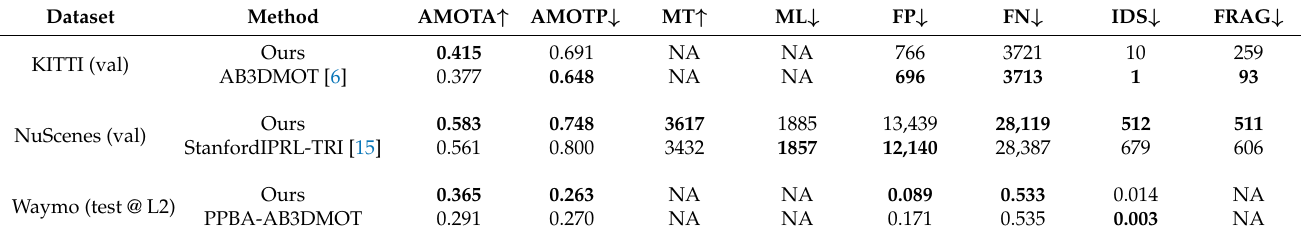
Table 2. Quantitative performance of our model on KITTI validation set, NuScenes validation set, and Waymo test set. AMOTA is the primary metric of these benchmarks. FP, FN IDS and FRAG are absolute numbers in the case of KITTI and NuScenes, while they are divided by the total number of objects in Waymo. The performance on Waymo is calculated at the difficulty of LEVEL